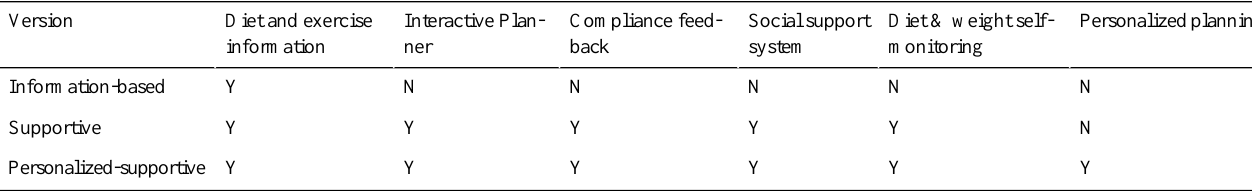
Table 1. Functionalities of different versions of the